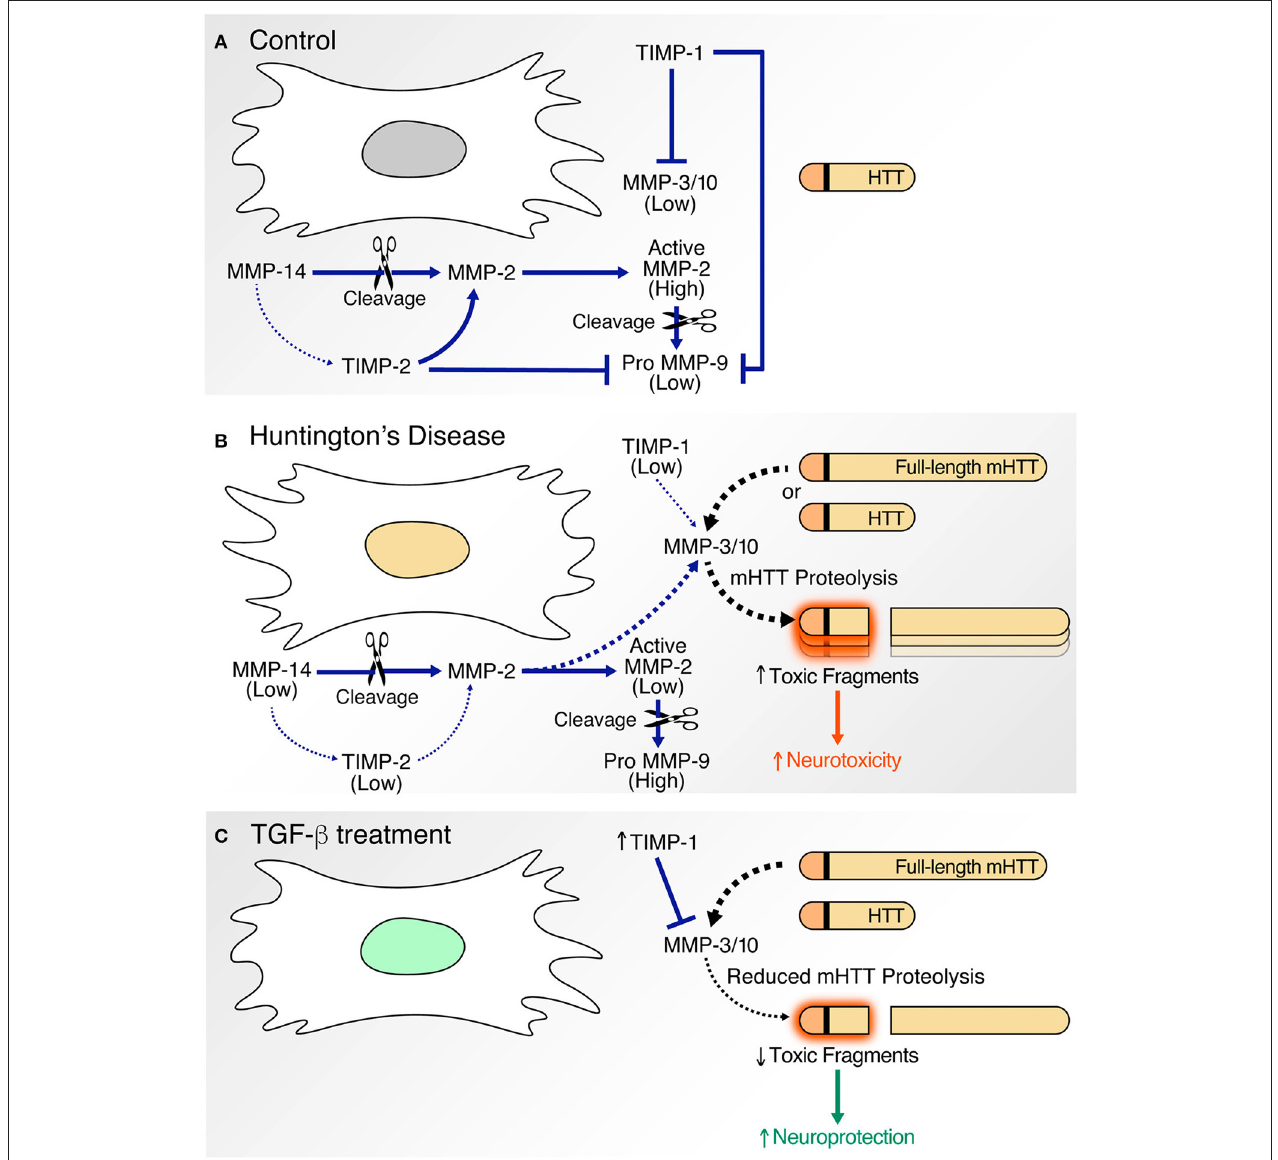
FIGURE 8 | Proposed model. In comparison to corrected C116-NSCs (A) , HD-NSCs express altered levels of MMPs and TIMPs (B) . (A) Under basal conditions, MMP-3/10 activity is kept in check by TIMP-1. MMP-14, MMP-2, and TIMP-2 form a trimolecular complex that facilitates activation of MMP-2, which in turn induces MMP-9. MMP-9 activity is greatly inhibited by TIMPs. (B) Decreased expression of TIMPs in HD-NSCs result in unregulated MMP activity as indicated by elevated MMP-3/10 expression. MMP-3/10 directly cleaves full-length mutant HTT (mHTT) leading to the production of toxic N-terminal polyQ fragments, consequently contributing to increased cell death in HD-NSCs. Decreased expression of TIMP-2 and MMP-14 result in reduced activation of MMP-2. Increased MMP-9 activity is observed possibly as a result of decreased TIMP expression. (C) TGF- β treatment upregulates TIMP-1 expression, which in turn inhibits MMP-3/10 activity. This inhibition prevents MMP-3/10-mediated cleavage of full-length mHTT, thereby decreasing the production of toxic N-terminal fragments and amelioration of cell death. Thus, TGF- β conferred neuroprotection is likely mediated through increased expression of